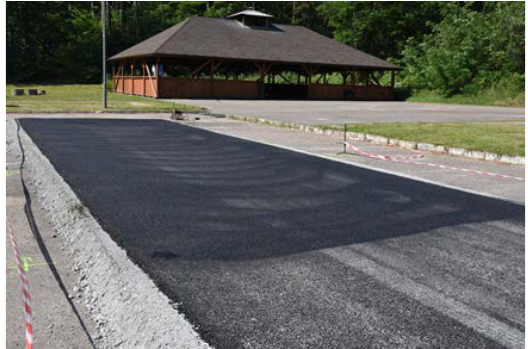
Figure 14. Binder course AC 16W before installation of different types of wearing courses.